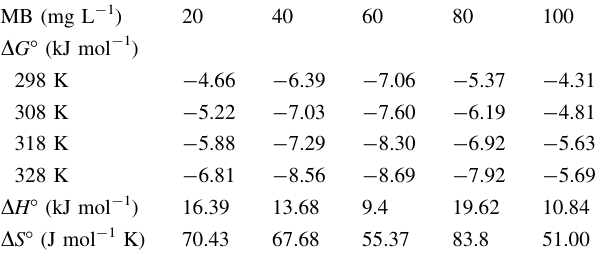
Fig. 11 Plots of Ln K C against 1/ T Table 3 Thermodynamic parameters of MB adsorption onto C-ZMN